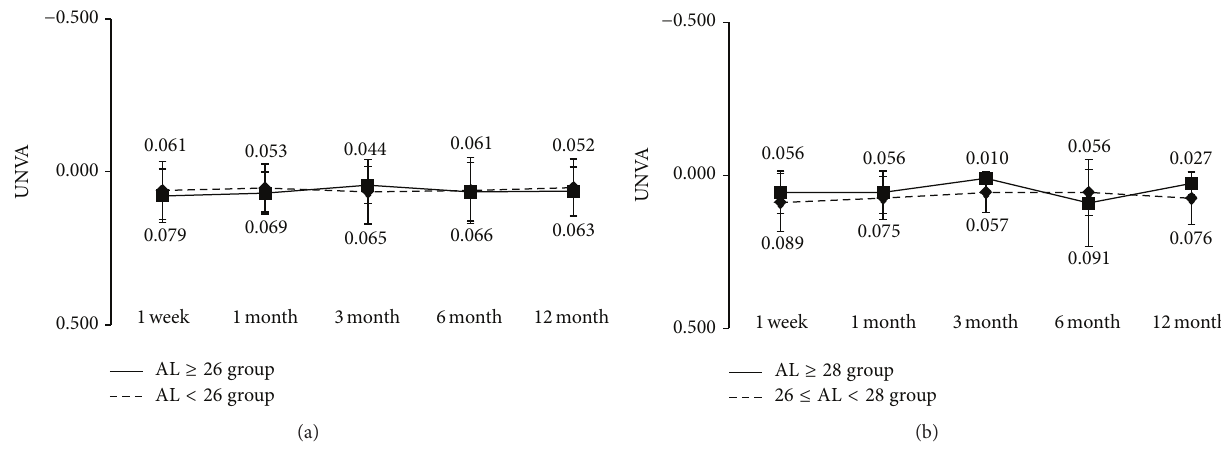
Figure 3: Uncorrected near visual acuity during 12-month follow-up after implantation of multifocal intraocular lens. (a) Eyes were divided into axial length of 26 mm or longer (AL ≥ 26 group) and less than 26 mm (AL < 26 group). (b) Eyes in AL ≥ 26 group were further divided into 26 ≤ AL < 28 group and AL ≥ 28 group. ∗ NS Mann-Whitney 𝑈